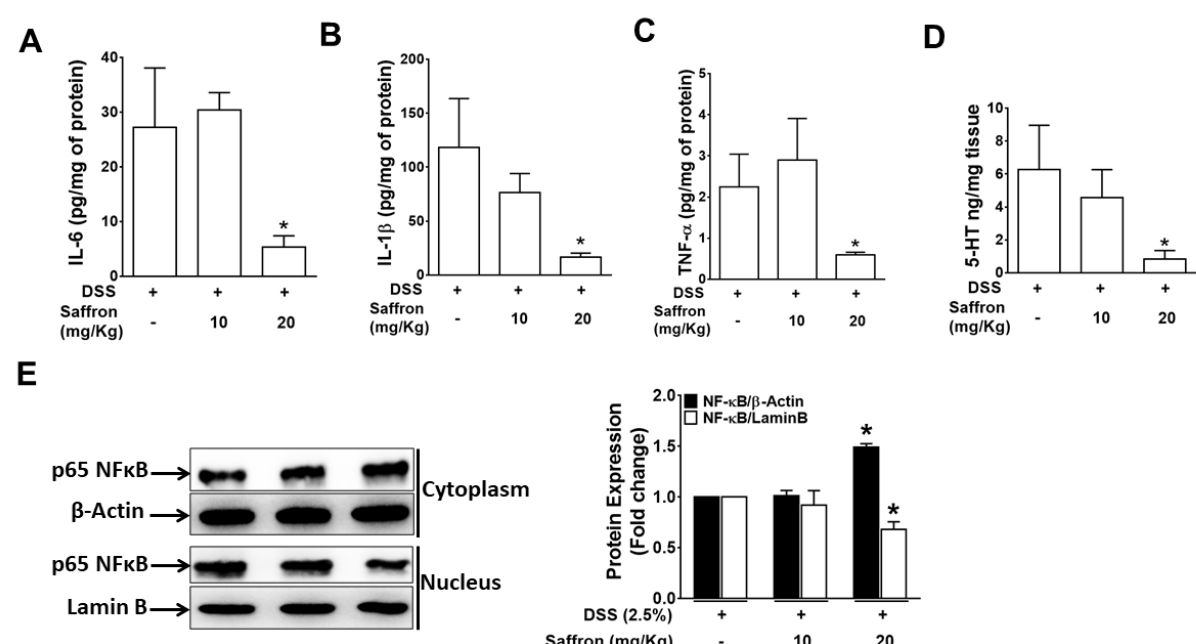
Figure 2. Pre-treatment with saffron inhibited the DSS-induced secretion of pro-inflammatory cytokines and the serotonin level in colon tissue. The supernatants from the homogenized colon tissue were analyzed for ( A ) IL-6, ( B ) IL-1 β , ( C ) TNF- α , and ( D ) Serotonin (5-HT). Data represent the mean ± SEM ( n = 4/group). * p < 0.05, compared to the vehicle-treated mice. ( E ) Cytoplasmic and nuclear protein extracted from colon tissues were analyzed for NF- κ B. Representative blots of the cytoplasmic and nuclear NF- κ B from the colon tissue of three random mice from each group. The bar graph represents the mean ± SEM. * p < 0.05, compared to the vehicle-treated mice.